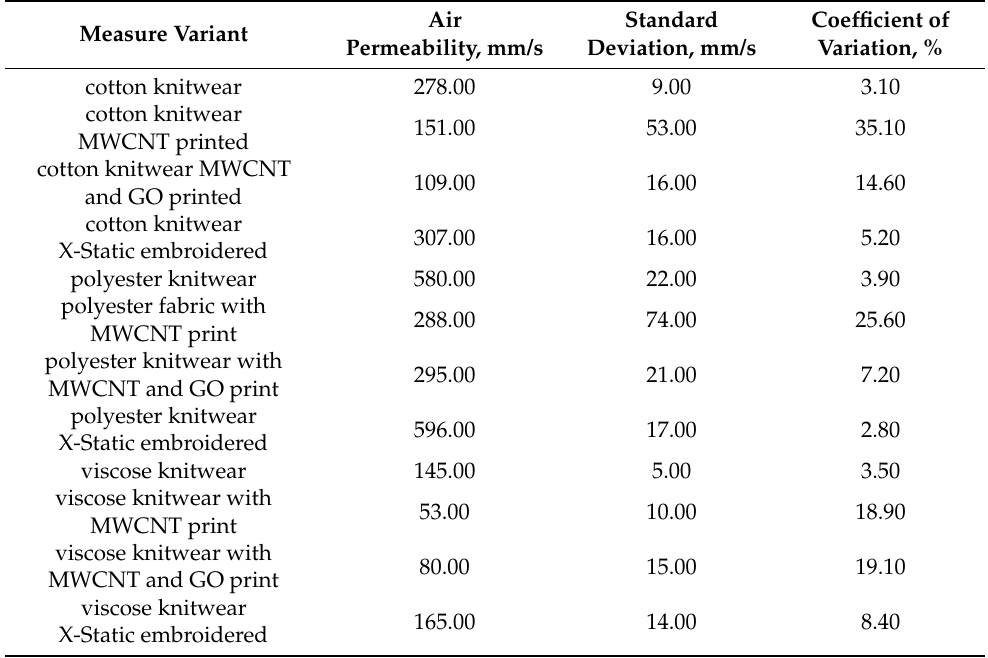
Table 4. Results of average values of air permeability in textile materials before and after